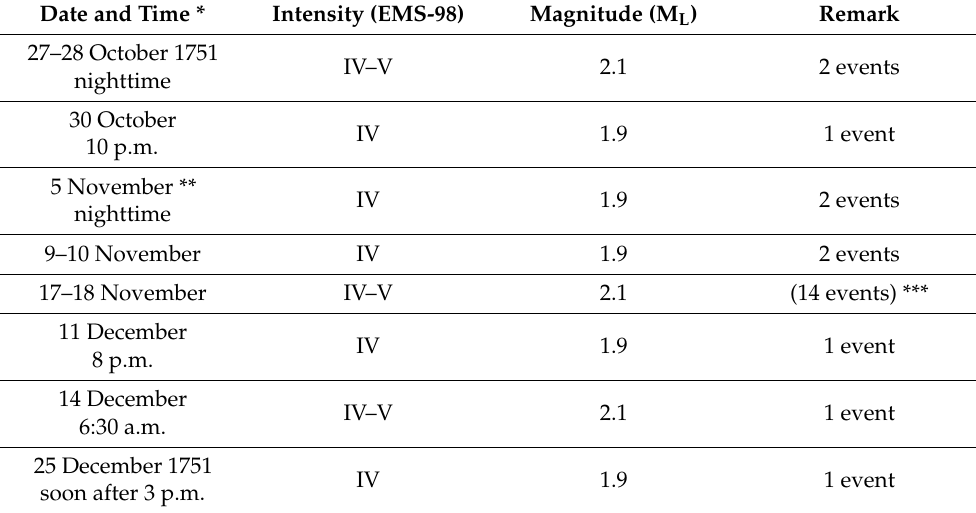
Table 2. Parameter estimates for the largest shocks on each